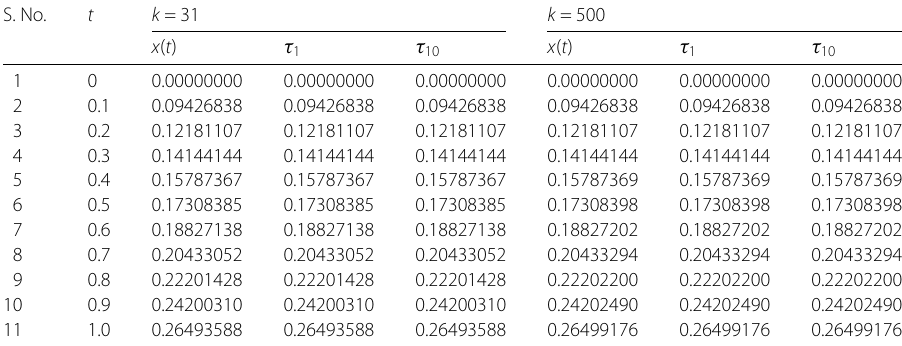
Table 5 Comparison between exact solution and approximate solution by using the JF iteration process for k = 31 and k = 500 S. No.